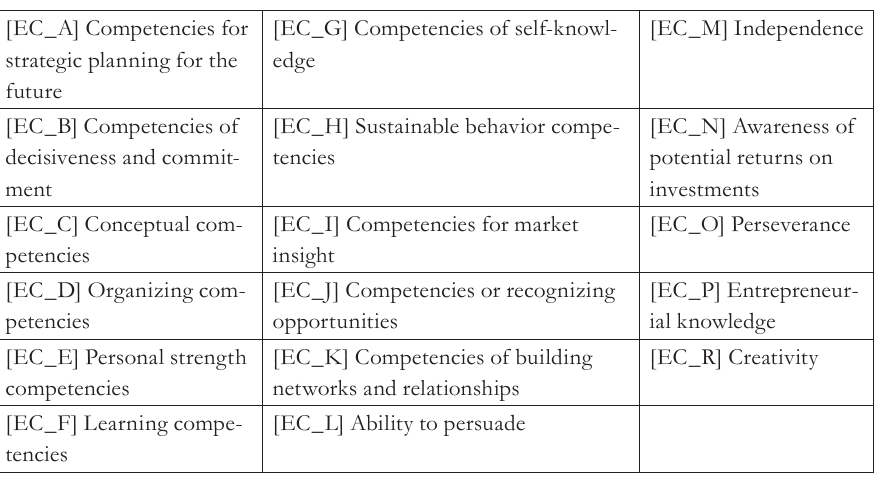
Tab. 1 – 17 EC constructs. Source: own